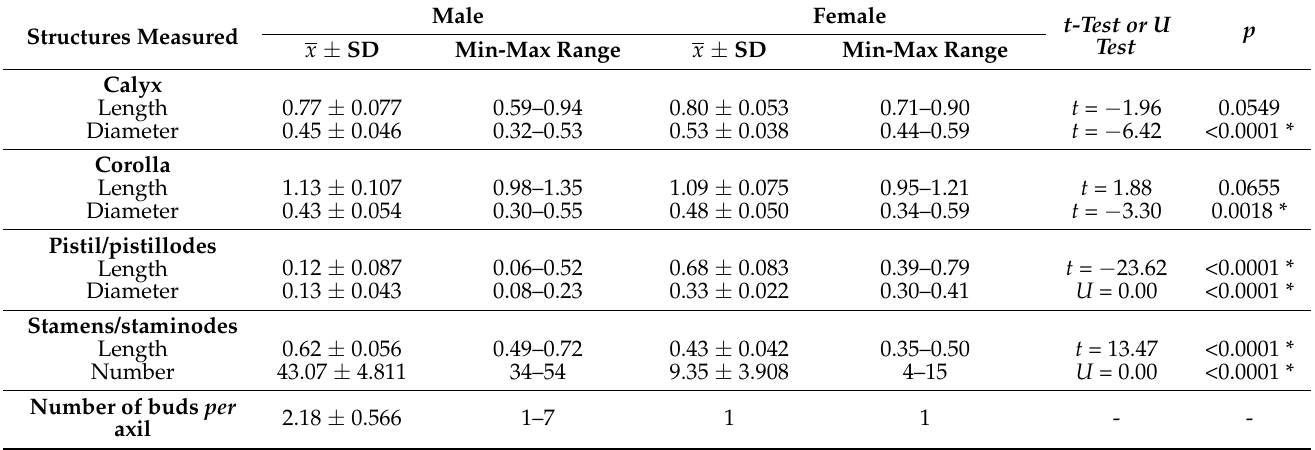
Table 2. Mean, standard deviation and variation in the morphometric measurements of floral whorls (centimeters), the number of stamens/staminodes, and the number of buds per axil (units) of individuals of D. sericea PESNT. x = mean; SD = standard